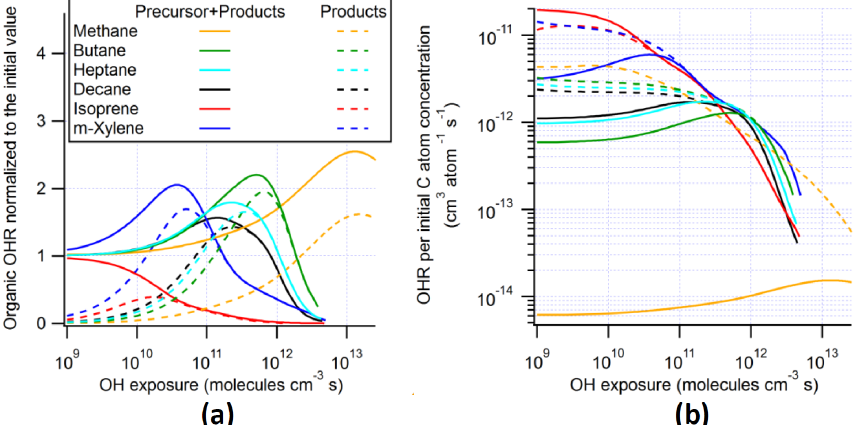
Figure 5. (a) OHR and (b) OHR per initial C atom concentration of the organics (including and excluding the precursor) as a function of OH exposure in the ambient cases with constant sunlight of the photooxidation of methane, butane, heptane, decane, isoprene, and m -xylene.